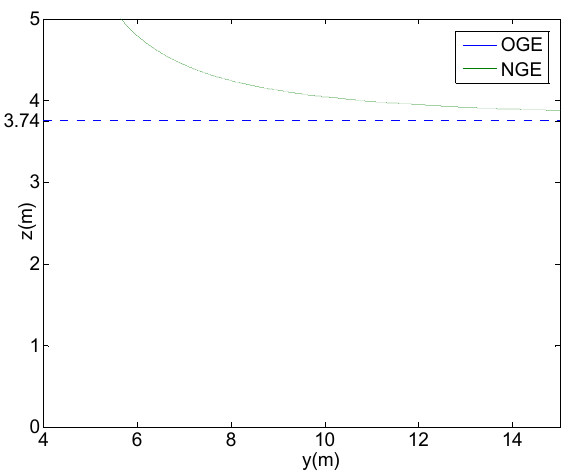
Figure 8. Trajectories of starboard vortex of Thrush 510G in OGE and NGE phases.